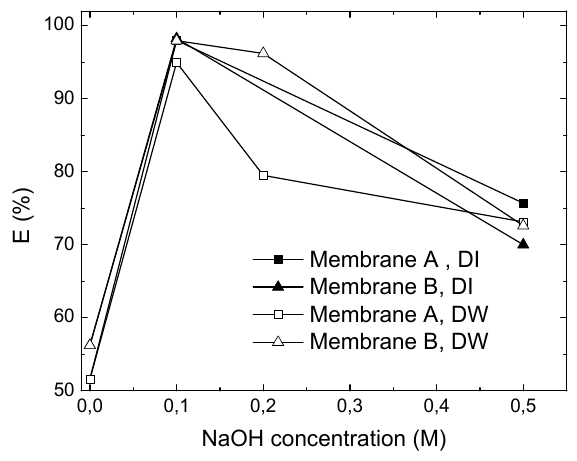
Figure 8. The effect of stripping agent concentration after 7 min. Both membranes